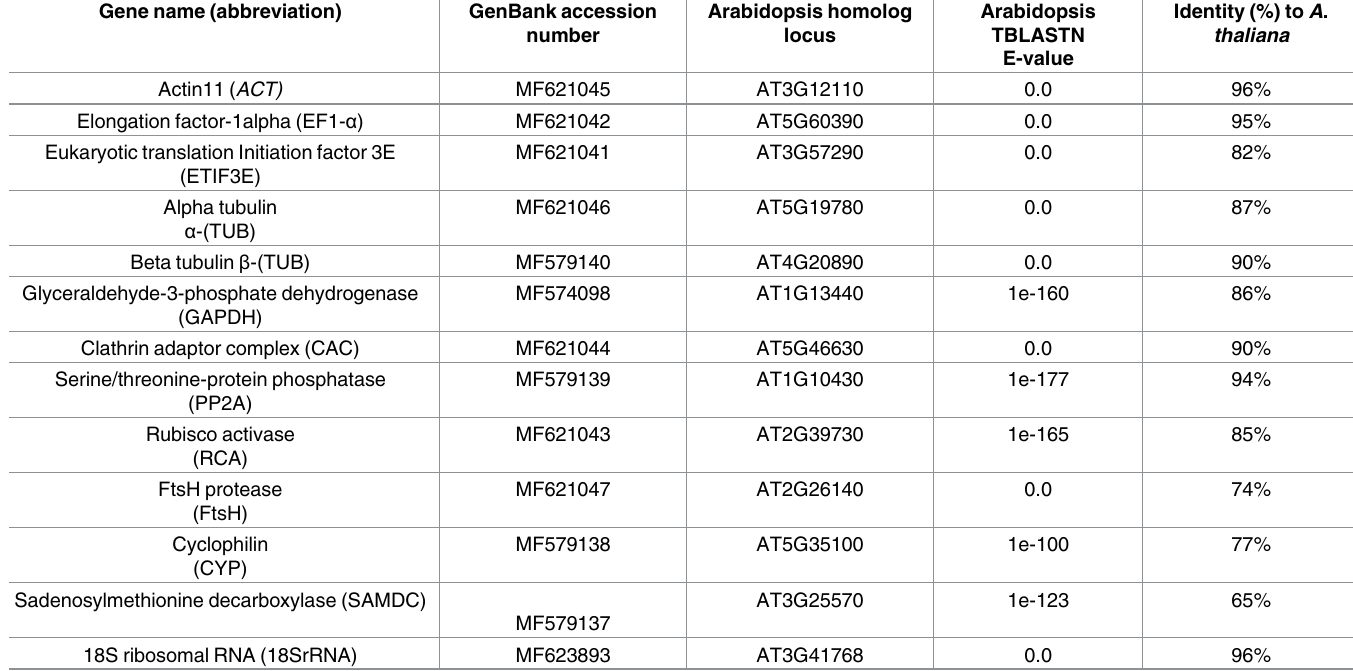
Table 1. Candidate referencegenes and their GenBank accessions in S . hispanica